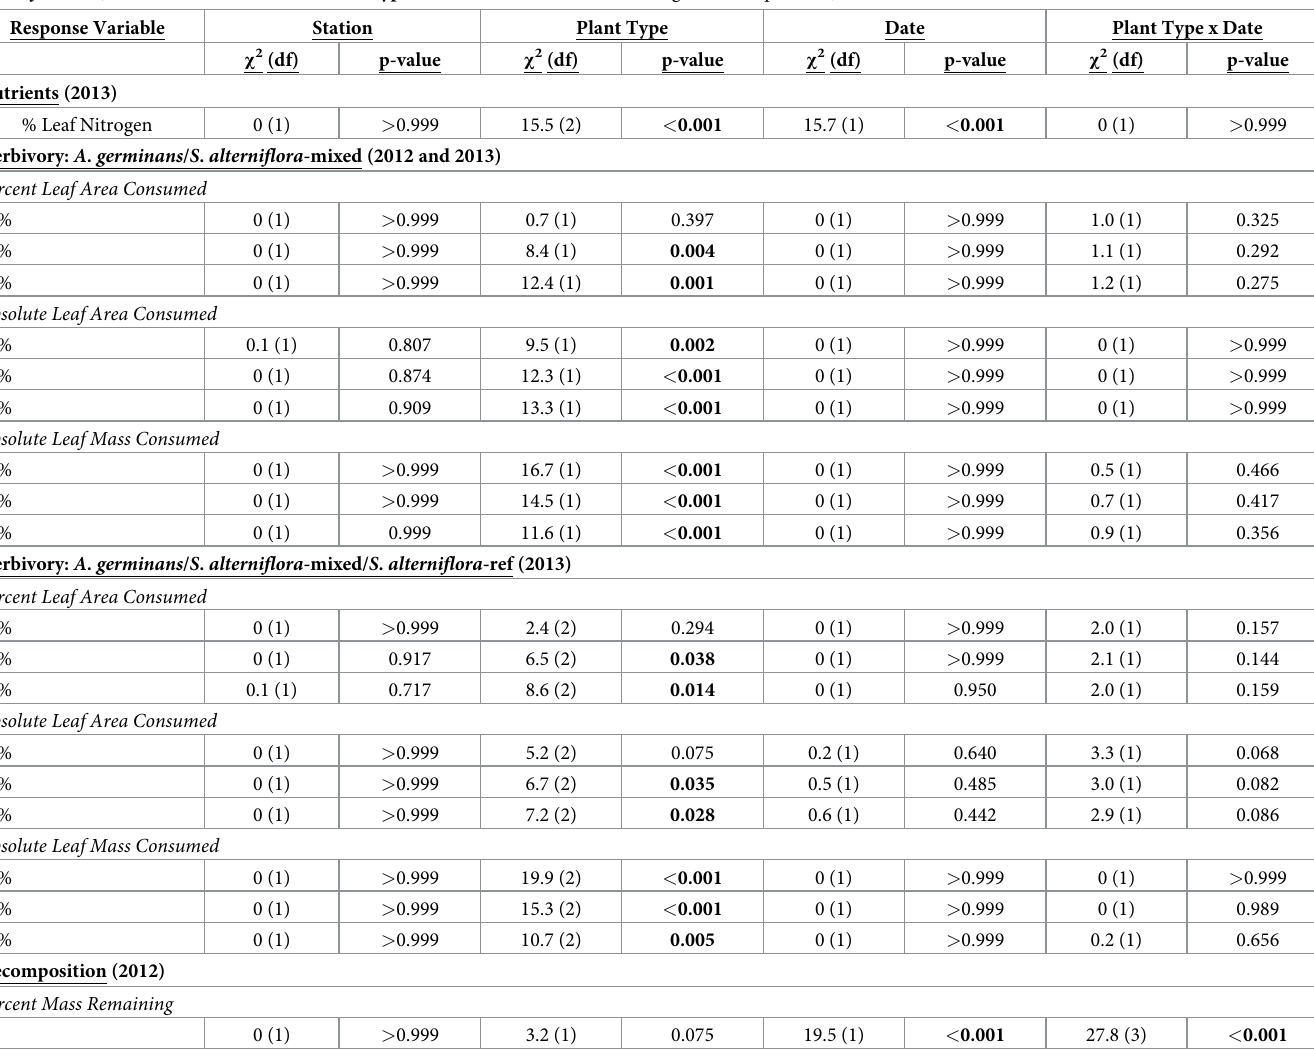
Table 1. Chi-squared ( χ 2 ), degrees of freedom (df), and p-values of factors within Likelihood Ratio Test: Station, Plant Type ( A . germinans , S . alterniflora -mixed, S . alterniflora -ref), Date, and interaction of Plant Type x Date. Bold P values indicate significance (p <